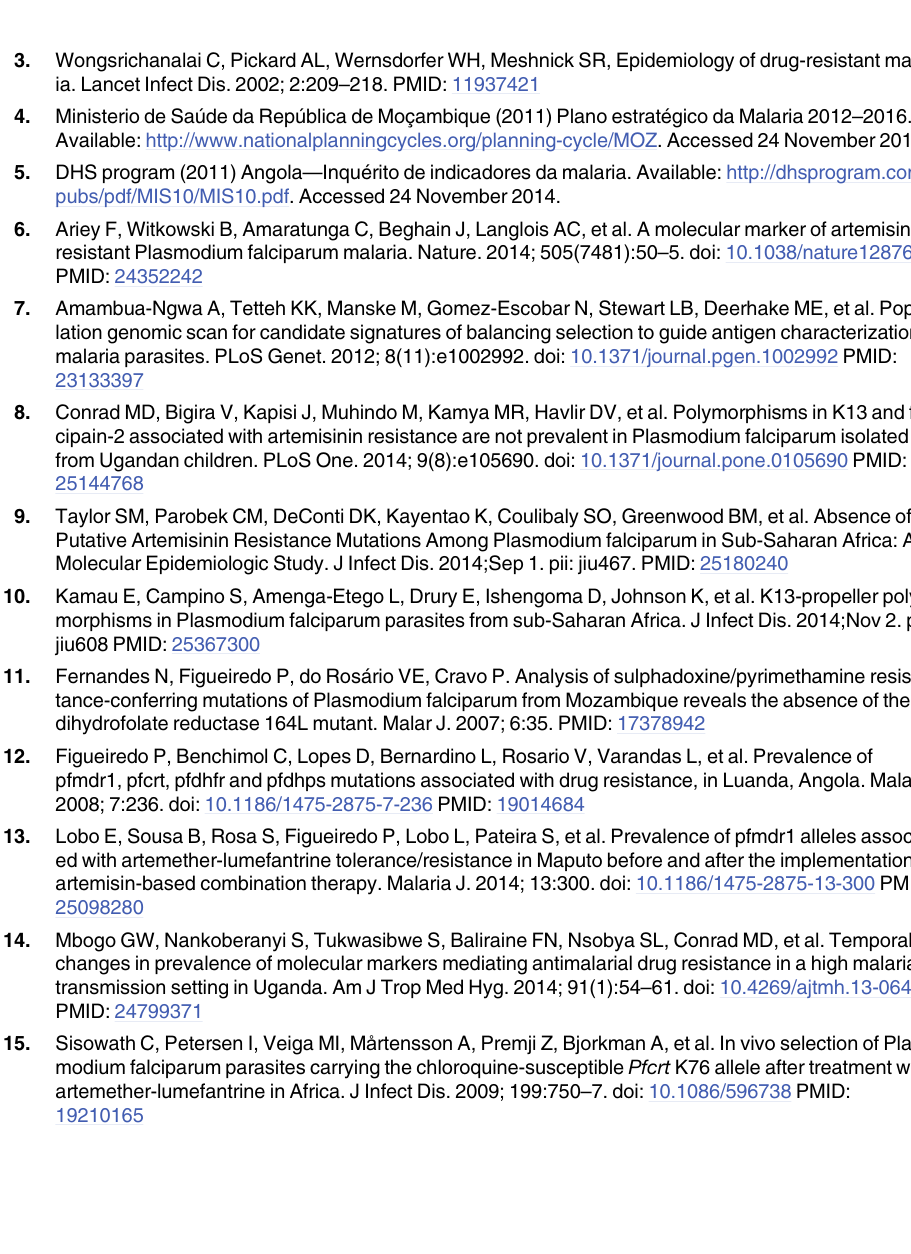
PLOS ONE | DOI:10.1371/journal.pone.0119215 March 19,